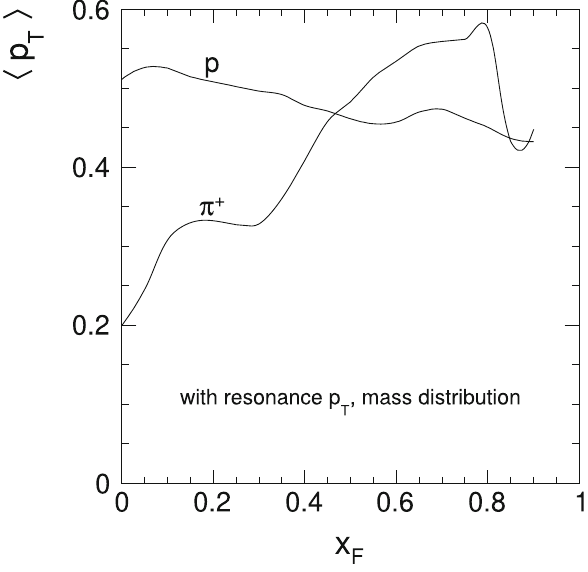
Fig. 156 Mean p T for decay protons and pions as a function of x F value at x F above 0.45. The relative factor between (cid:4) p T (cid:5) for protons and pions,